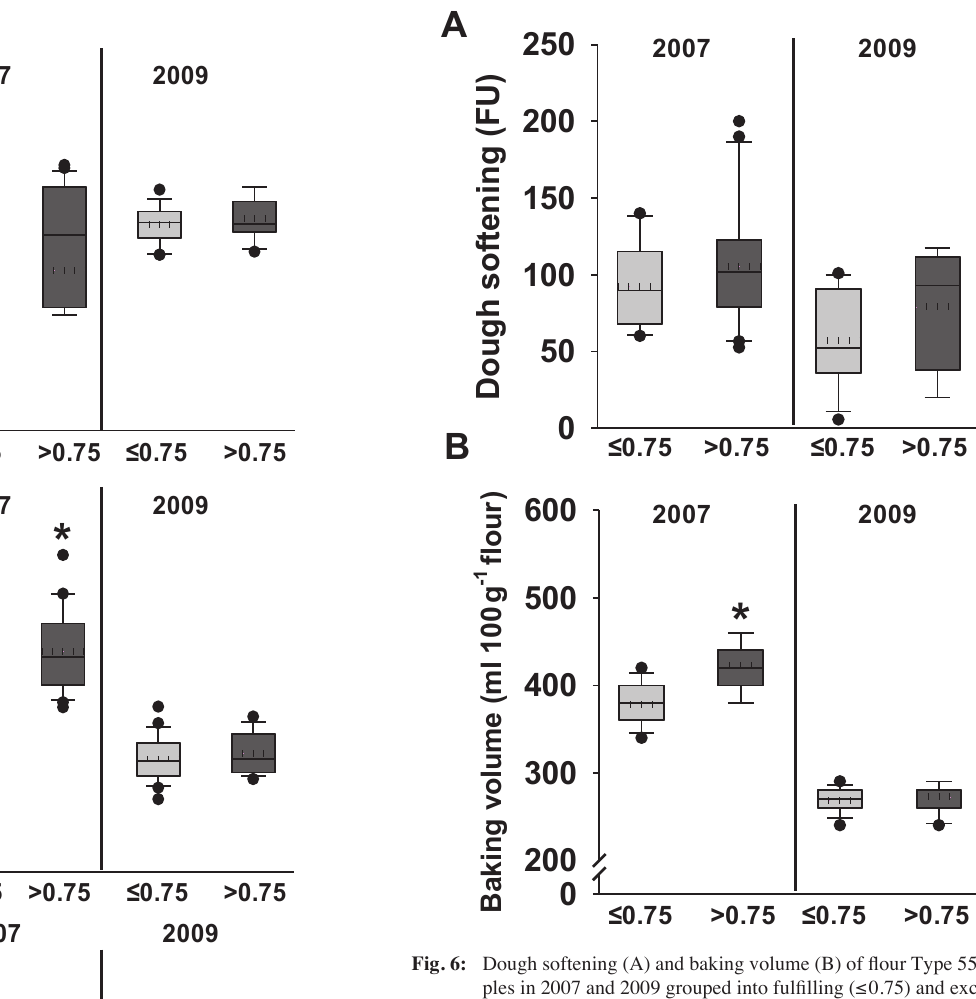
crop maize with the highly susceptible cultivar led to the highest DON contamination of flour. Again the high risk coming from pre- crop maize enhancing toxin accumulation in wheat grain is empha- sized as reported before (e.g. d ill -m acky and j oneS , 2000; B eck and l ePSchy , 2000).